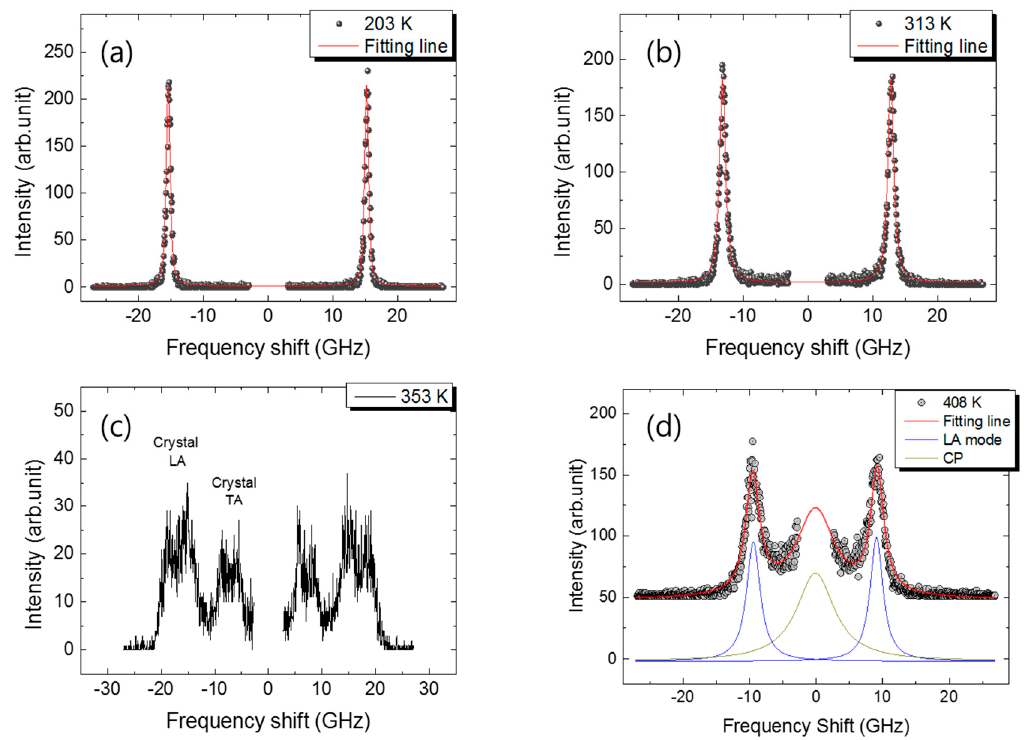
Figure 1. Brillouin scattering spectra corresponding to ( a ) the quenched glassy state; ( b ) the ultraviscous (or supercooled liquid) state; ( c ) the crystalline state and ( d ) the liquid state. Each state was attained sequentially upon heating. The solid lines denote the best-fitted results as described in the text.